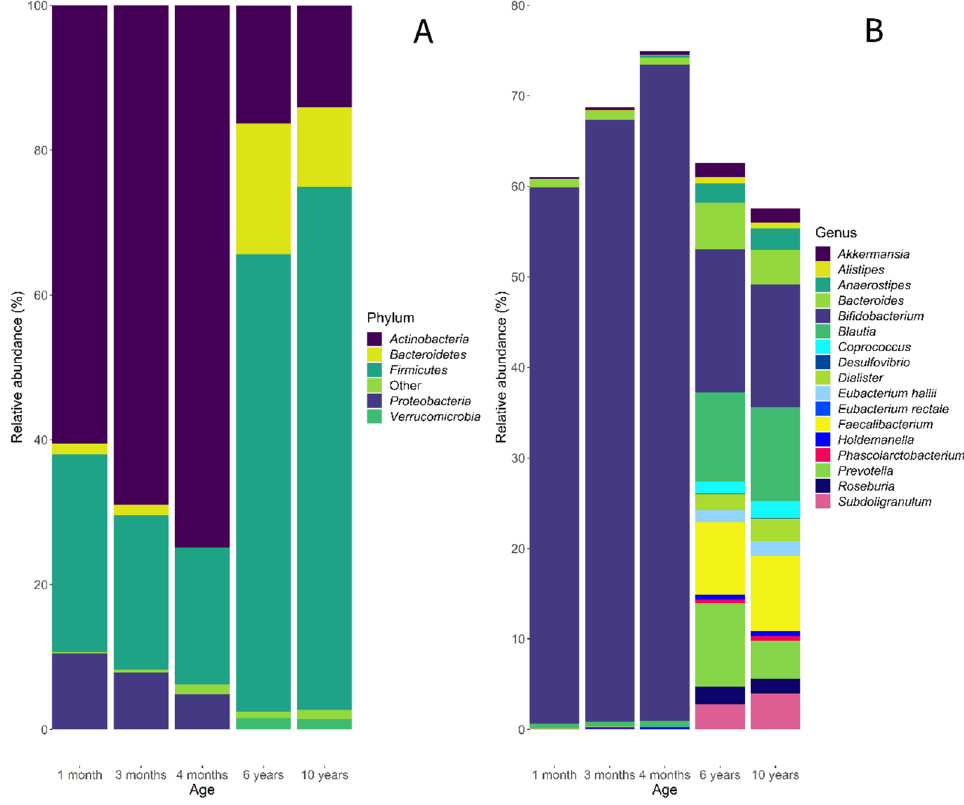
Figure 2. Gut microbiota composition over time. ( A ) The average relative abundance of the 6 most abundant phyla in the first 12 years of life are shown with Actinobacteria predominating in infancy and Firmicutes becoming the predominant phylum in childhood. Phyla with an abundance < 1% are plotted as “Other”. ( B ) The composition of average relative abundance of SCFA producer genera in the first 12 years of life is shown. In infancy, Bifidobacterium is the dominant genus of SCFA producers with the composition becoming more diverse in childhood. Note that y-axes are not equivalent.